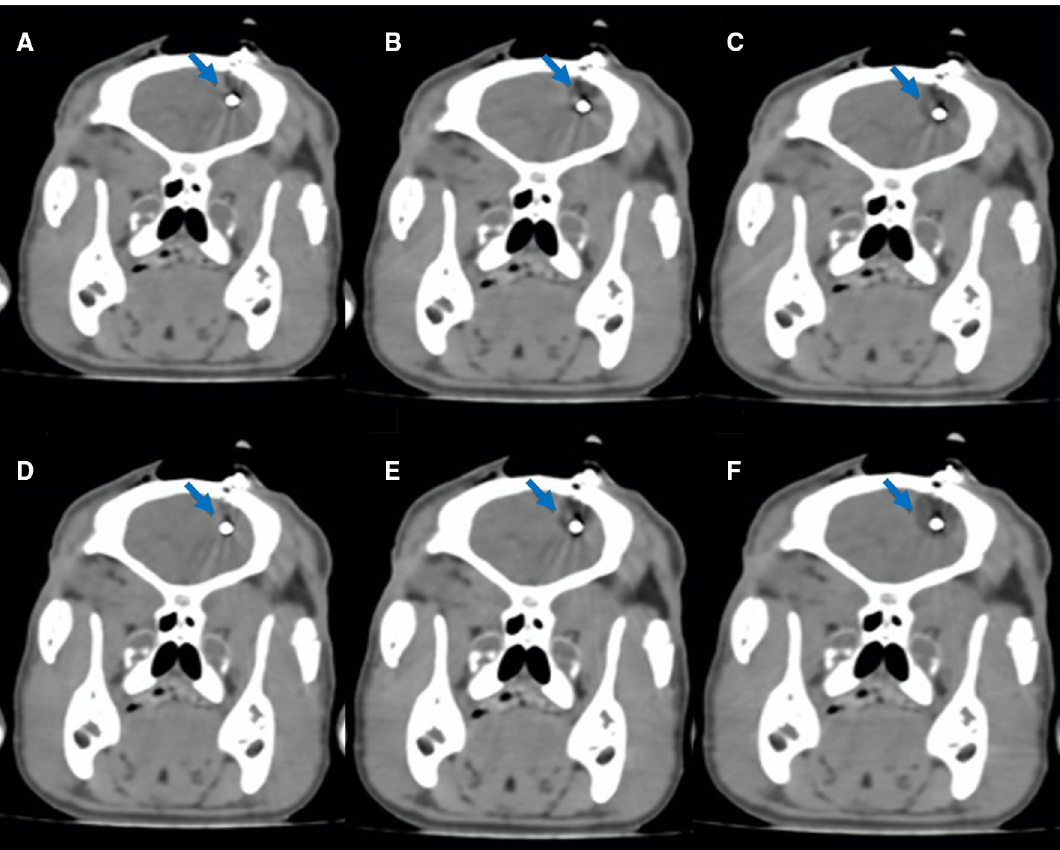
Figure 1. Metal artefact reduced coronal section CT scans of the brain after cryoablation (blue arrow). ( A – C ) Ice formation during the first freeze cycle; ( A ) after 0.5 min, ( B ) after 1.5 min, and ( C ) after 3 min. ( D – F ) Ice formation during the second freeze cycle; ( D ) Lesion size after 0.5 min, ( E ) after 1.5 min, and ( F ) after 3 min. No artefact caused by the probe was seen after metal artefact